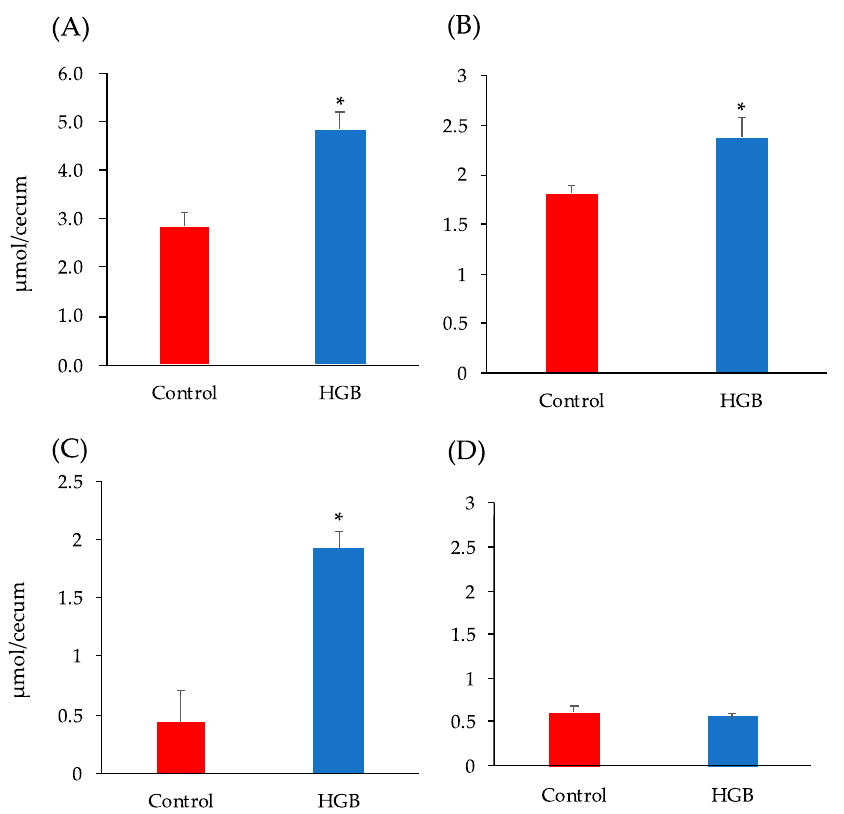
Figure 2. Short-chain fatty acid (SCFA) content in the cecal digesta of mice fed the test diets. ( A ) Total SCFA, ( B ) Acetate, ( C ) Propionate, ( D ) Other SCFA (the sum of the concentrations of formate, n -butyrate, iso -butyrate, iso -valerate, and valerate). Bars represent means and standard error of the mean (SE), n = 8. Means marked by an asterisk differ significantly (Student’s t -test, * p < 0.05). HGB; high β -glucan barley.